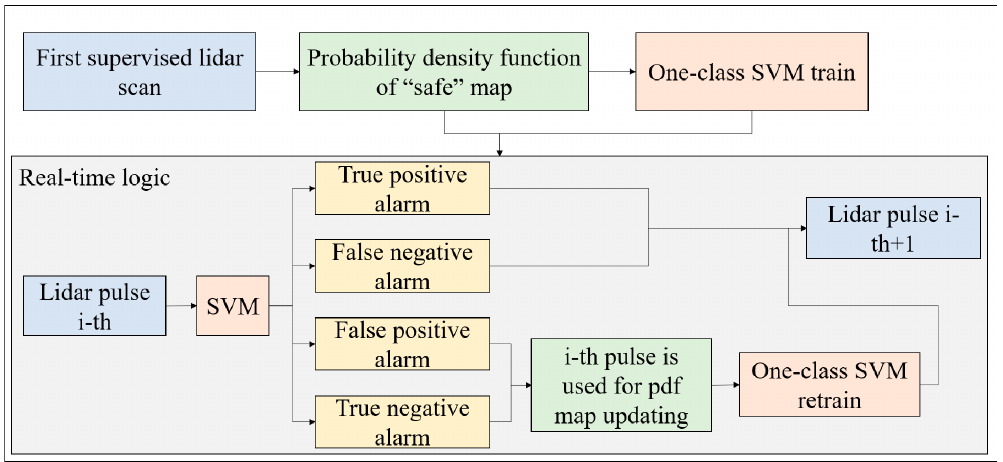
Figure 2. Schematics of the classification algorithm logic. Abbreviations: SVM, support-vector machine. At first, a first LiDAR scan was performed in the area, when there is no smoke and fire. Then, the probability density function maps of both backscattering and backscattering standard deviation as a function of the distances were calculated. For any bin of the distance map, N number of points were generated following the pdf at that distance and the SVM was trained. So, the SVM was ready for the real-time application. The i-th laser pulse was classified by the SVM and there were